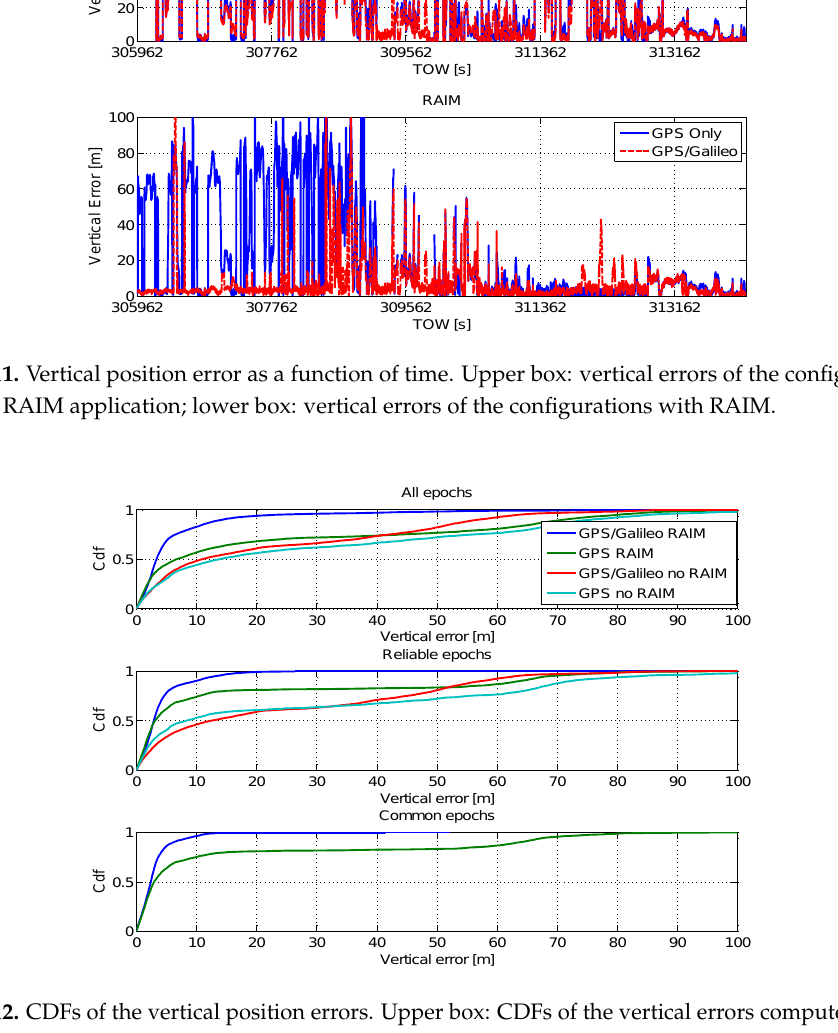
Figure 12. CDFs of the vertical position errors. Upper box: CDFs of the vertical errors computed using all epochs; central box: CDFs computed using only the reliable epochs; lower box: CDFs computed using only common